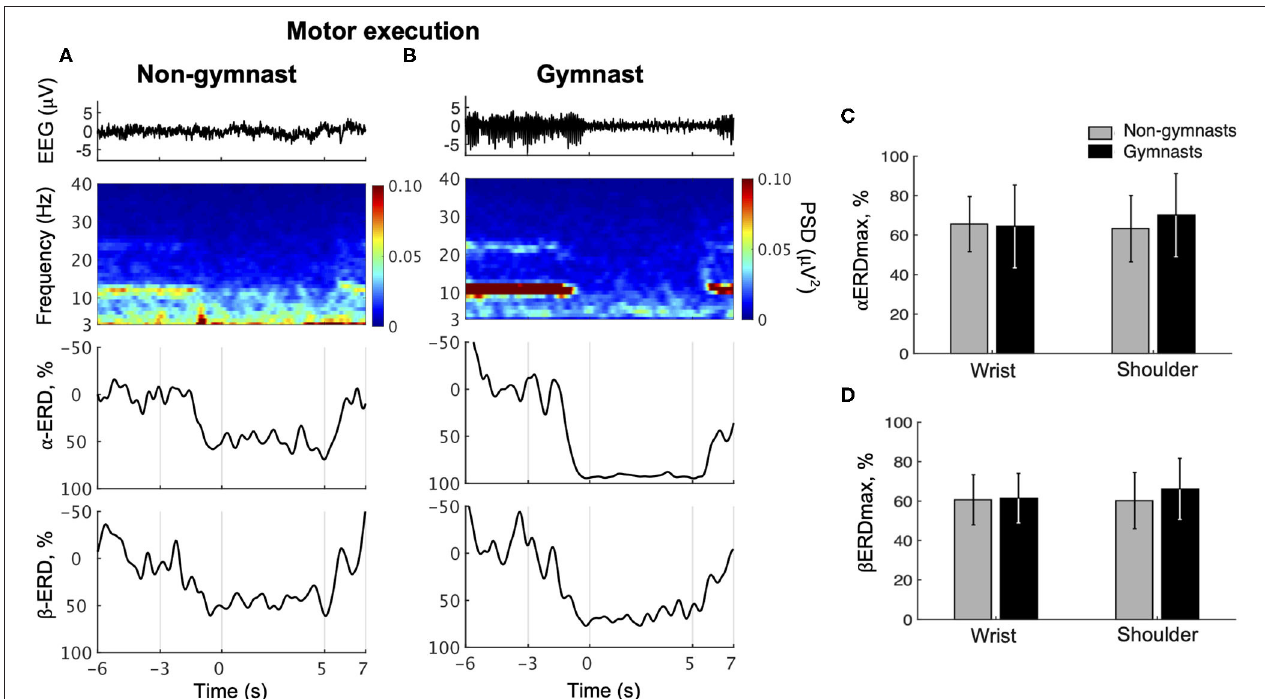
FIGURE 3 | Results from physiological experiments for motor execution. Typical time courses of single-trial EEG, time-frequency map, α -band event-related desynchronization (ERD), and β -band in wrist dorsiflexion motor execution are shown for non-gymnast (A) and gymnast (B) participants. Note that participants performed wrist dorsiflexion motor execution from 0 to 5s. Group data (mean ± S.D.) for the maximal peak of ERD both in the α - ( α ERDmax) (C) and in the β -bands ( β ERDmax) (D) during motor execution are shown across groups and tasks. The gray bars represent the data for non-gymnasts, while the black bars represent the data for gymnasts. No significant differences were observed across groups and